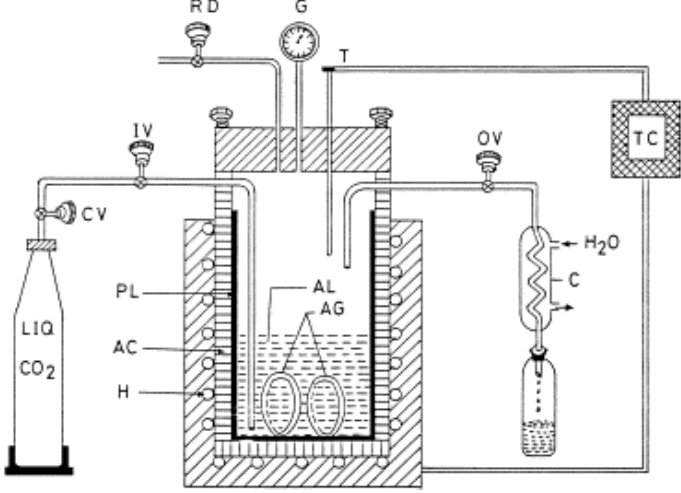
Figure 6. Schematic representation of an equipment for scCO 2 drying: H-Heater, AC-autoclave, PL-pyrex liner, CV-CO 2 cylinder valve, IV-inlet valve, OV-outlet valve, C-condenser, RD-rupture disk, G-pressure gauge, T-thermocouple, TC-temperature controller, AL-alcohol (depend on the solvent used for the sol-gel process), AG-aerogel. (Reprinted with permission from [75] Copyright Elsevier, 1999).